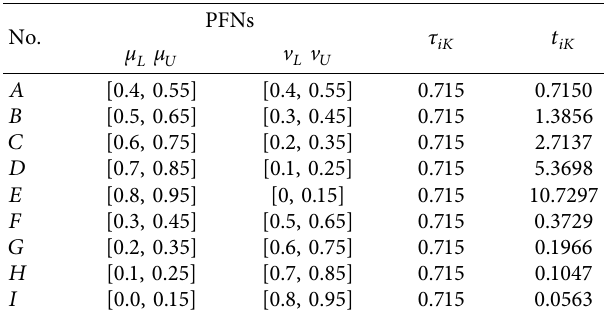
Figure 4: Steps to obtain weight by using Pythagorean fuzzy AHP. Table 4: Pythagorean fuzzy scale set interval weight